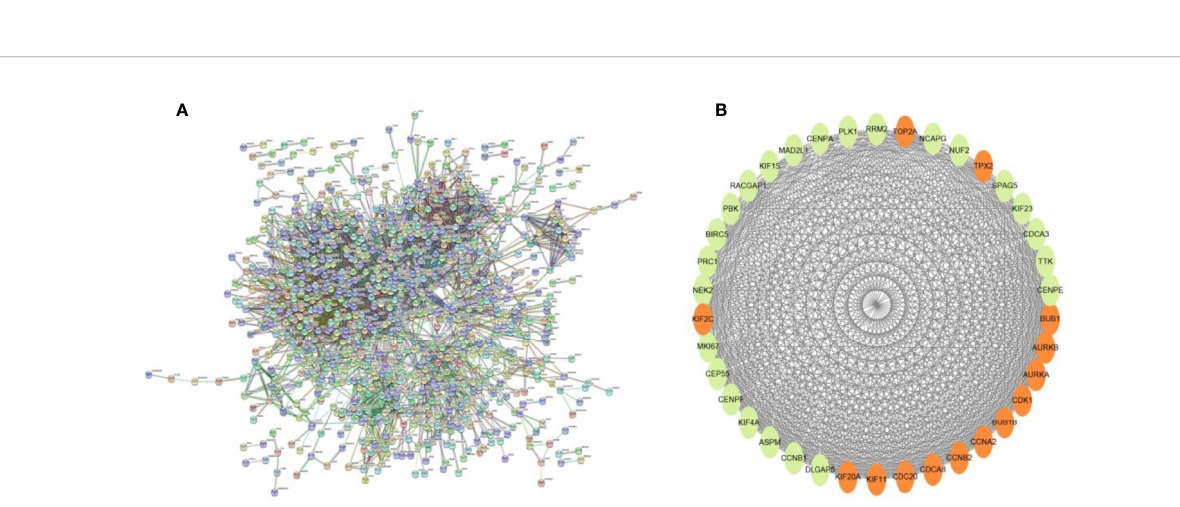
FIGURE 10 | (A) PPI network diagram of 13 sets of genes. (B) The 14 core gene networks are related to 13 gene sets, namely: TOP2A, TPX2, BUB1, AURKB, AURKA, CDK1, BUB1B, CCNA2, CCNB2, CDCA8, CDC20, KIF11, KIF20A and